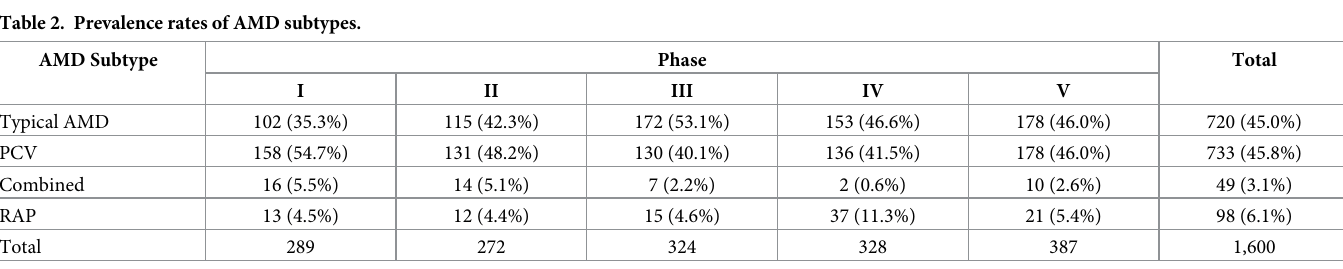
Table 2. Prevalence rates of AMD